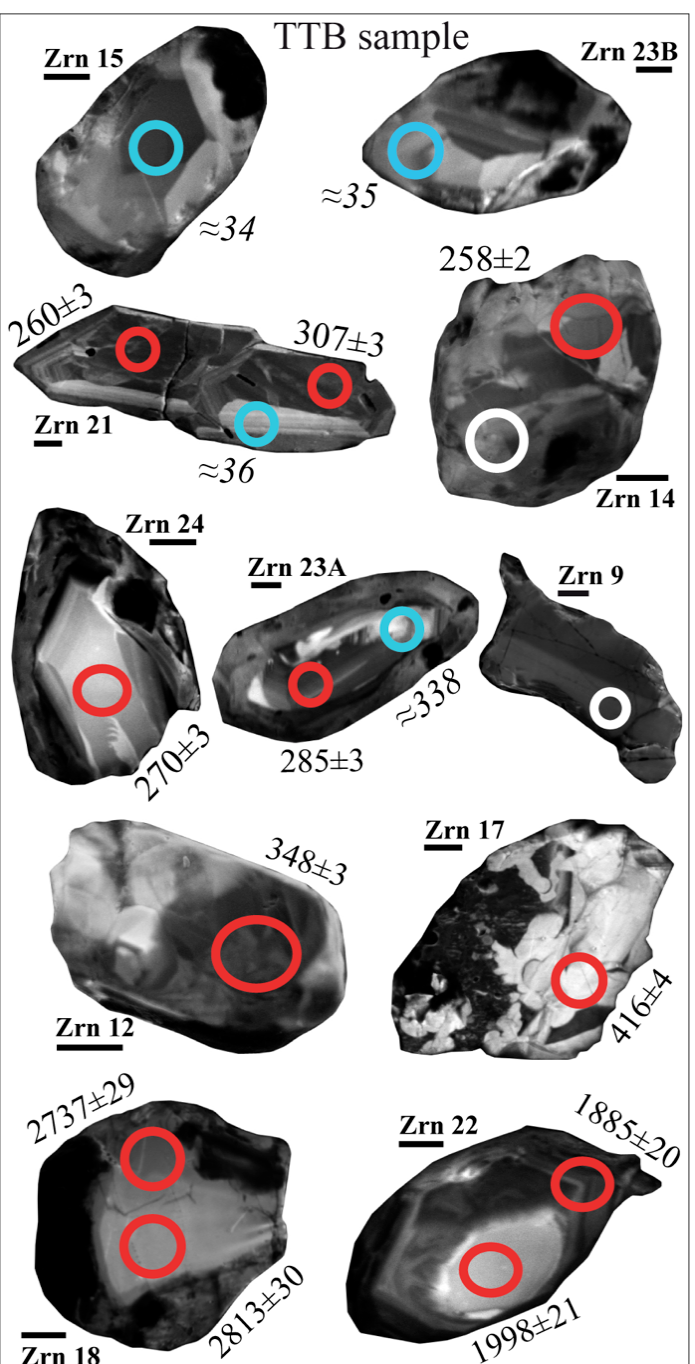
Figure 7. VPSE images of the dated zircons in the TTB sample. Red and blue circles indicate the spot location of the 206 Pb / 238 U ages with % U-Pb discordance < ± 10% and those between 10% and 27%, respectively. White circles indicate the discordant ages. The ages > 1.4 Ga in zrn18 and zrn22 derive from the 206 Pb / 207 Pb ratios. Other symbols are as described in Figure 6.